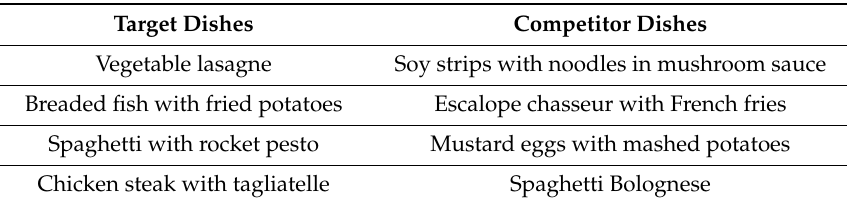
Table 2. Target and Competitor